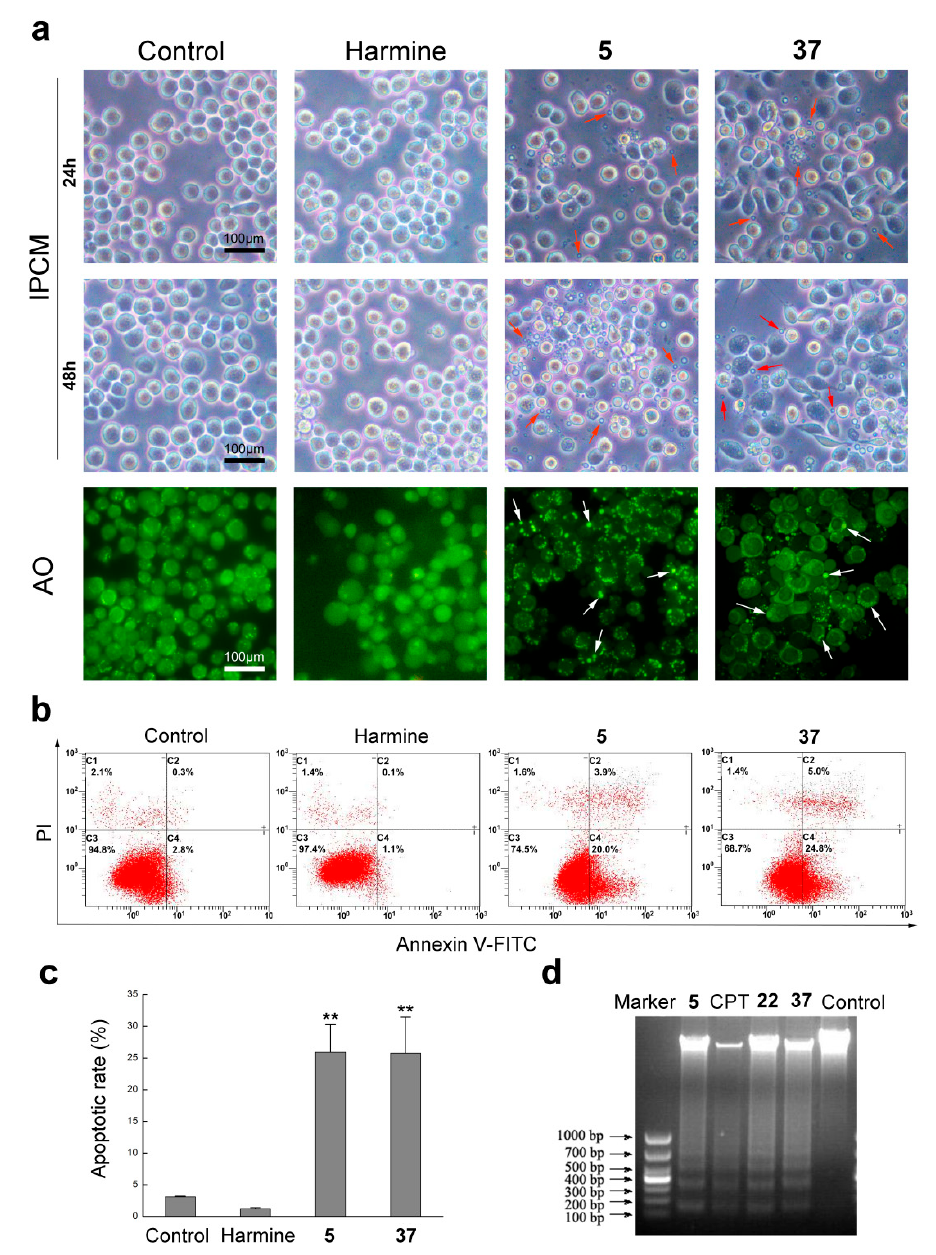
Figure 3. Analysis of apoptosis in Sf9 cells treated with 12.5 μ g mL − 1 5 and 37 . ( a ) Representative photographs of cell morphological change induced by harmine, 5 and 37 for 24 and 48 h, respectively. IPCM: inverted phase contrast microscopy; AO: acridine orange. Red and white arrows represent apoptosis bodies; ( b , c ) Apoptotic rate of cells induced by 12.5 μ g mL − 1 5 and 37 for 24 h; ( d ) Agarose gel electrophoresis analysis of genomic DNA of cells treated by 12.5 μ g mL − 1 5 , 22 and 37 with CPT as a positive control. CPT: camptotothecin. Note: (**) p < 0.01 in comparison to the control.